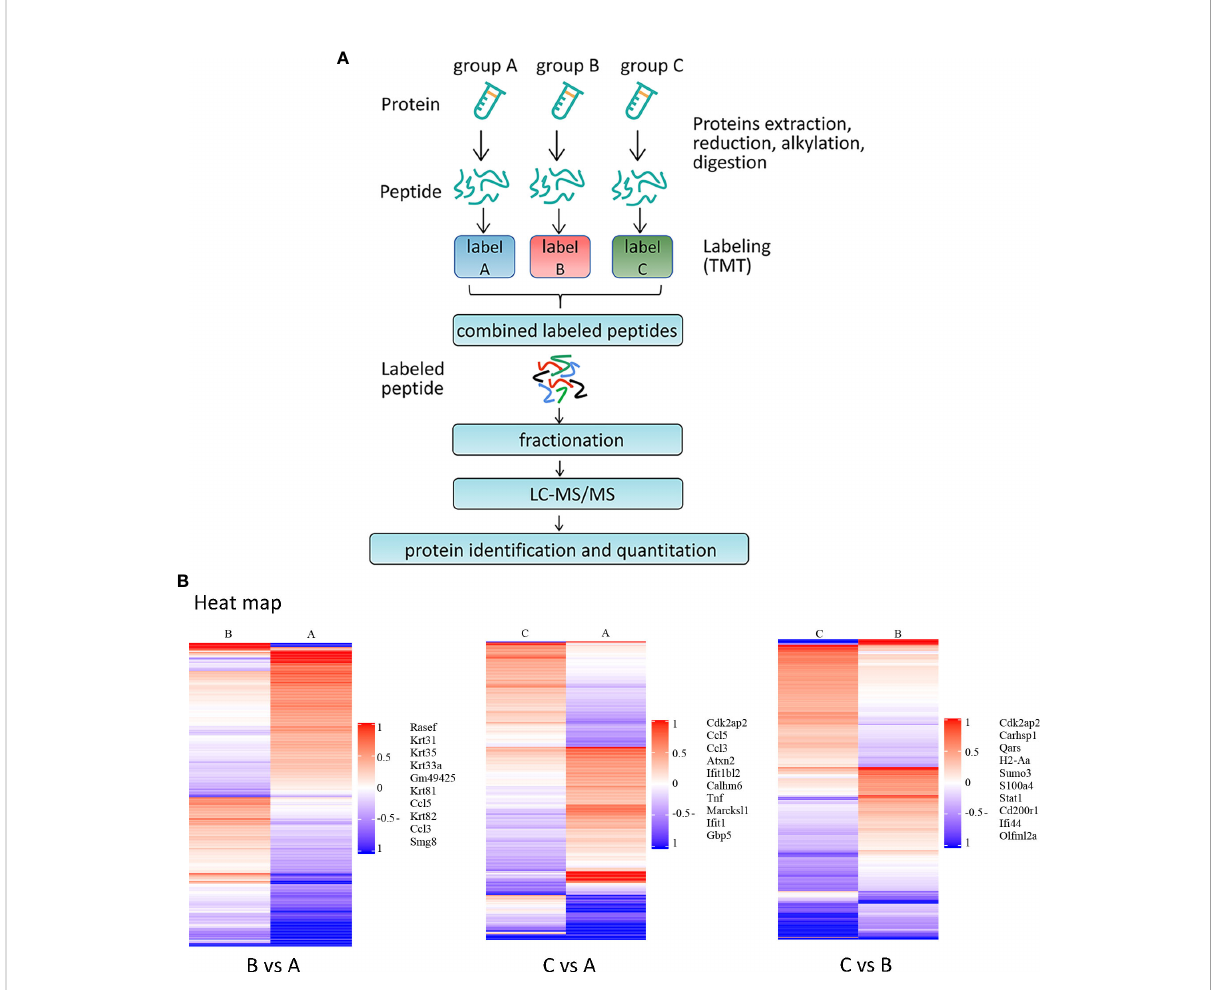
FIGURE 5 Proteomic analysis of BMDMs from MRL/lpr after primary stimulation and secondary stimulation (A) Schematic overview of TMT-based quantitative proteomic analysis of BMDMs samples from MRL/lpr mice. The grouping and culture of BMDMs are shown in Figure 2A. Samples were reduced, alkylated and digested with trypsin. Samples labelled with TMT were analysed by LC-MS/MS. (B) Results of cluster analysis of DEPs. The target protein set ’ s quantitative information is fi rst standardized to the (-1,1) range. The Complexheatmap R package (R Version 3.4) was used to classify the two dimensions of sample and protein expression at the same time (distance algorithm: Euclidean, connection method: Average linkage). The tree-type heatmap represents the hierarchical clustering results. For each sample, the abscissa represents sample information, and for each row, it represents a protein; for this reason, an ordinate signi fi es a protein with substantially differing expression levels. Colors in the heatmap re fl ect up- and down-regulated proteins, respectively, based on the log2 normalization approach, where red represents signi fi cantly up-regulated proteins, blue represents signi fi cantly down-regulated proteins, and gray represents no protein quantitative information. Names of representative proteins are shown.